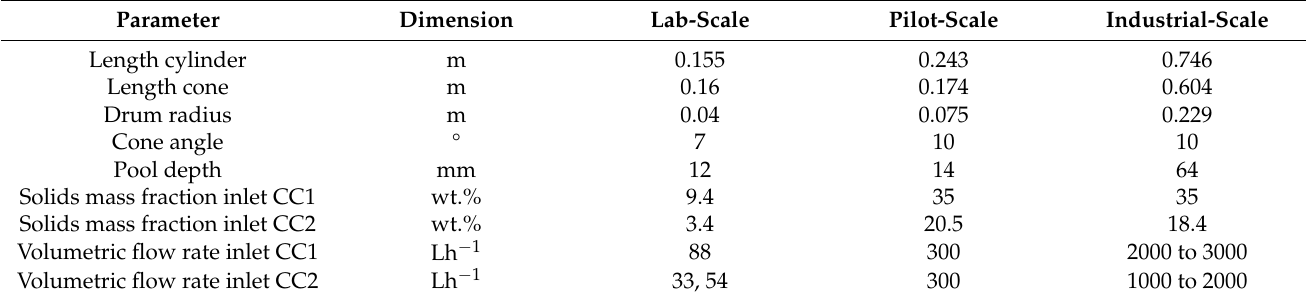
Table 2. Geometry and process parameters of the decanter centrifuges used.